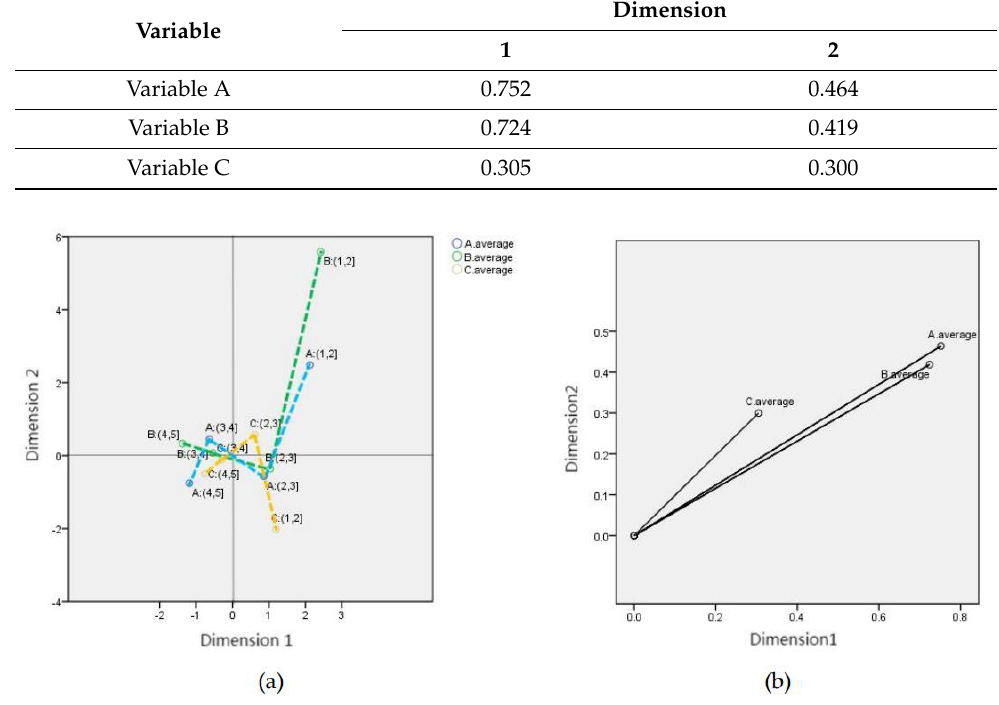
Figure 6. MCA results of the three variables: ( a ) Joint plot of the category points. ( b ) Discrimination measures of the three variables.